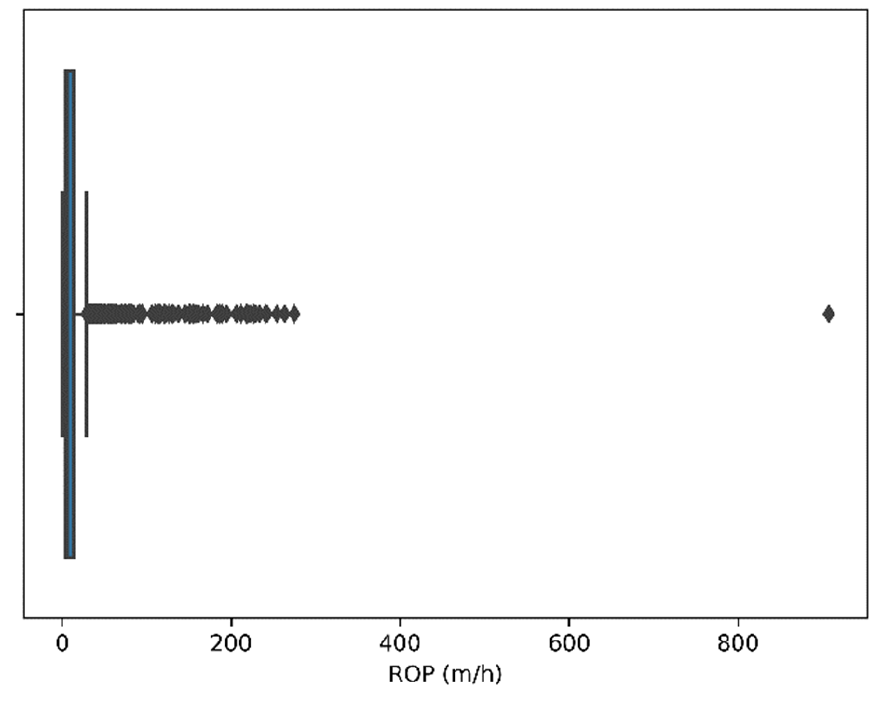
Figure 8. ROP boxplot. Rotary speed above 200 (rpm) is considered an outlier (Figure 9).